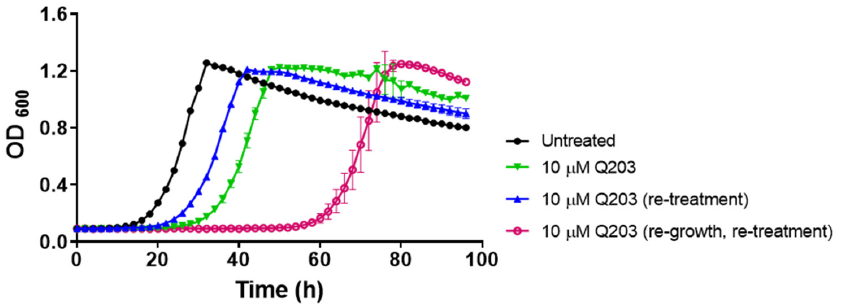
Figure 2. The outgrowth of M. smegmatis bd -KO in presence of Q203 is not due to selection of mutant harboring compensatory mutations. After eventual growth resumption in presence of Q203 at ~40 h (green curve), the bacteria were re-treated with Q203 by diluting into fresh 7H9 complete medium containing the drug (blue curve) or re-grown in drug-free 7H9 complete medium for 16 h, and subsequently again diluted into fresh 7H9 complete medium containing the drug. Data are Mean ± SD from two independent experiments (biological replicates), each comprising three technical